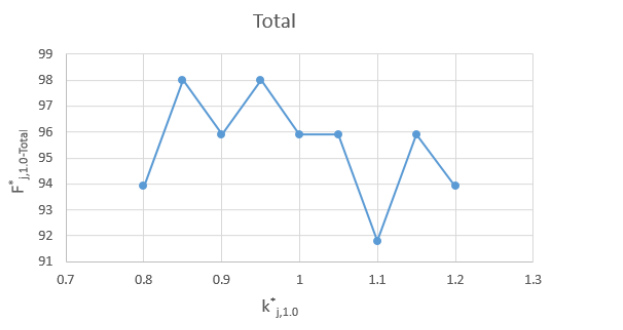
Figure 10. Value of F* j, 1.0-Train , F* j, 1.0-Test, and F* j, 1.0-Total and sensitivity function for the scenario with k* 1.0 .